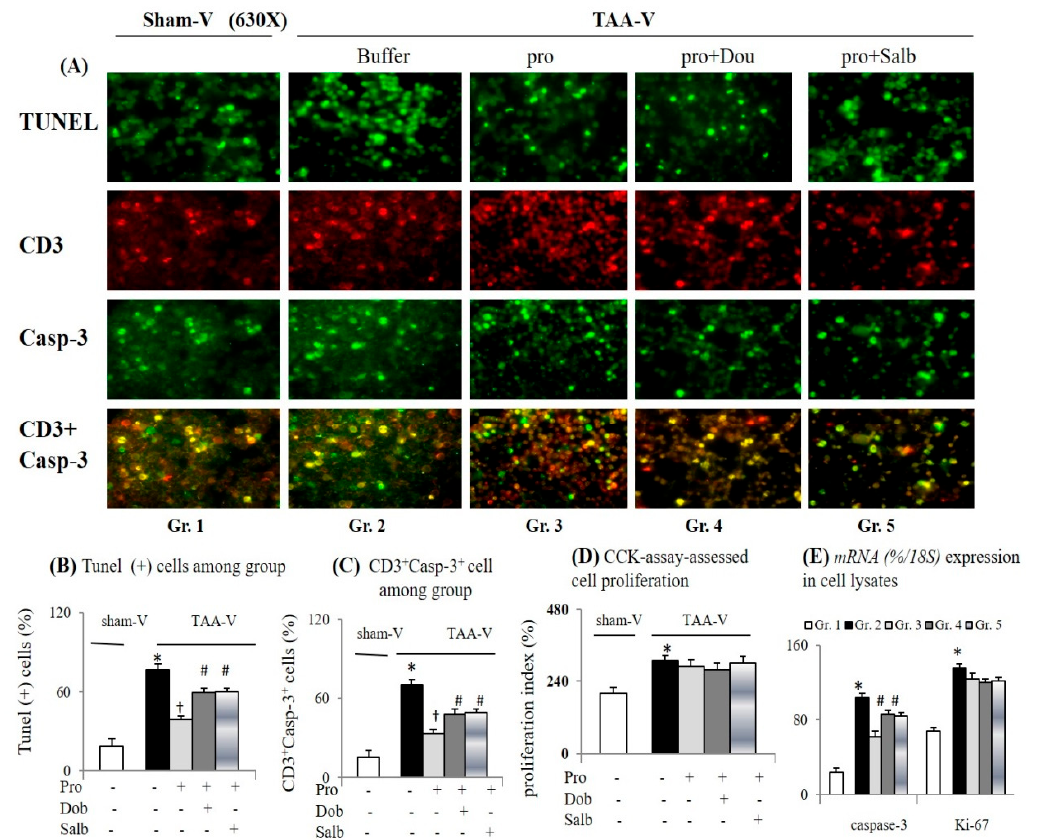
Figure 6. Acute propranolol incubation inhibited apoptosis of splenic Th cells isolated from cirrhotic mice. ( A – C ) Representative images and bar graphs of TUNEL/CD3 plus Casp-3 immunofluorescence (IF) staining of naïve Th cells isolated from sham-V and TAA-V mice with acute incubation of propranolol (pro), pro + dobutamine (dob) or pro + salbutamol (sal); ( D ) cell-counting kit (CCK)-assessed proliferation index; ( E ) mRNAs (%/18S) levels in cell lysates; Gr. 1: buffer-treated sham-V group cells; Gr. 2: buffer-treated TAA-V group’ cells; Gr. 3: pro-treated TAA-V group’ cells; Gr. 4: pro + dob-treated TAA-V group’ cells; Gr. 5: pro + sal-treated TAA-V group’ cells. * p < 0.05 vs. sham-V group; † p < 0.05 vs. TAA-V group; # p < 0.05 vs. TAA-pro group.